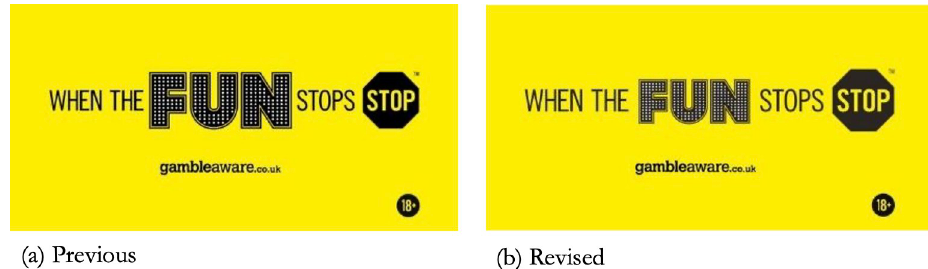
Fig 1. The Senet Group’s responsible gambling campaign tagline. In the original campaign imagery (a) the font size for the word “FUN” was larger and the second “STOP” was smaller than the version currently in use. On the 1 st of June 2015, the Senet Group announced that “Senet has slightly altered the relative size of the words ‘Fun’ and ‘Stop’ in its yellow advertising strip, ‘When the Fun Stops, Stop’, to bring the two symbols into better balance” (b) (Source: Senet Group press release titled Senet Group runs new burst of #BadBetty advertising and strengthens regulation ) [73].